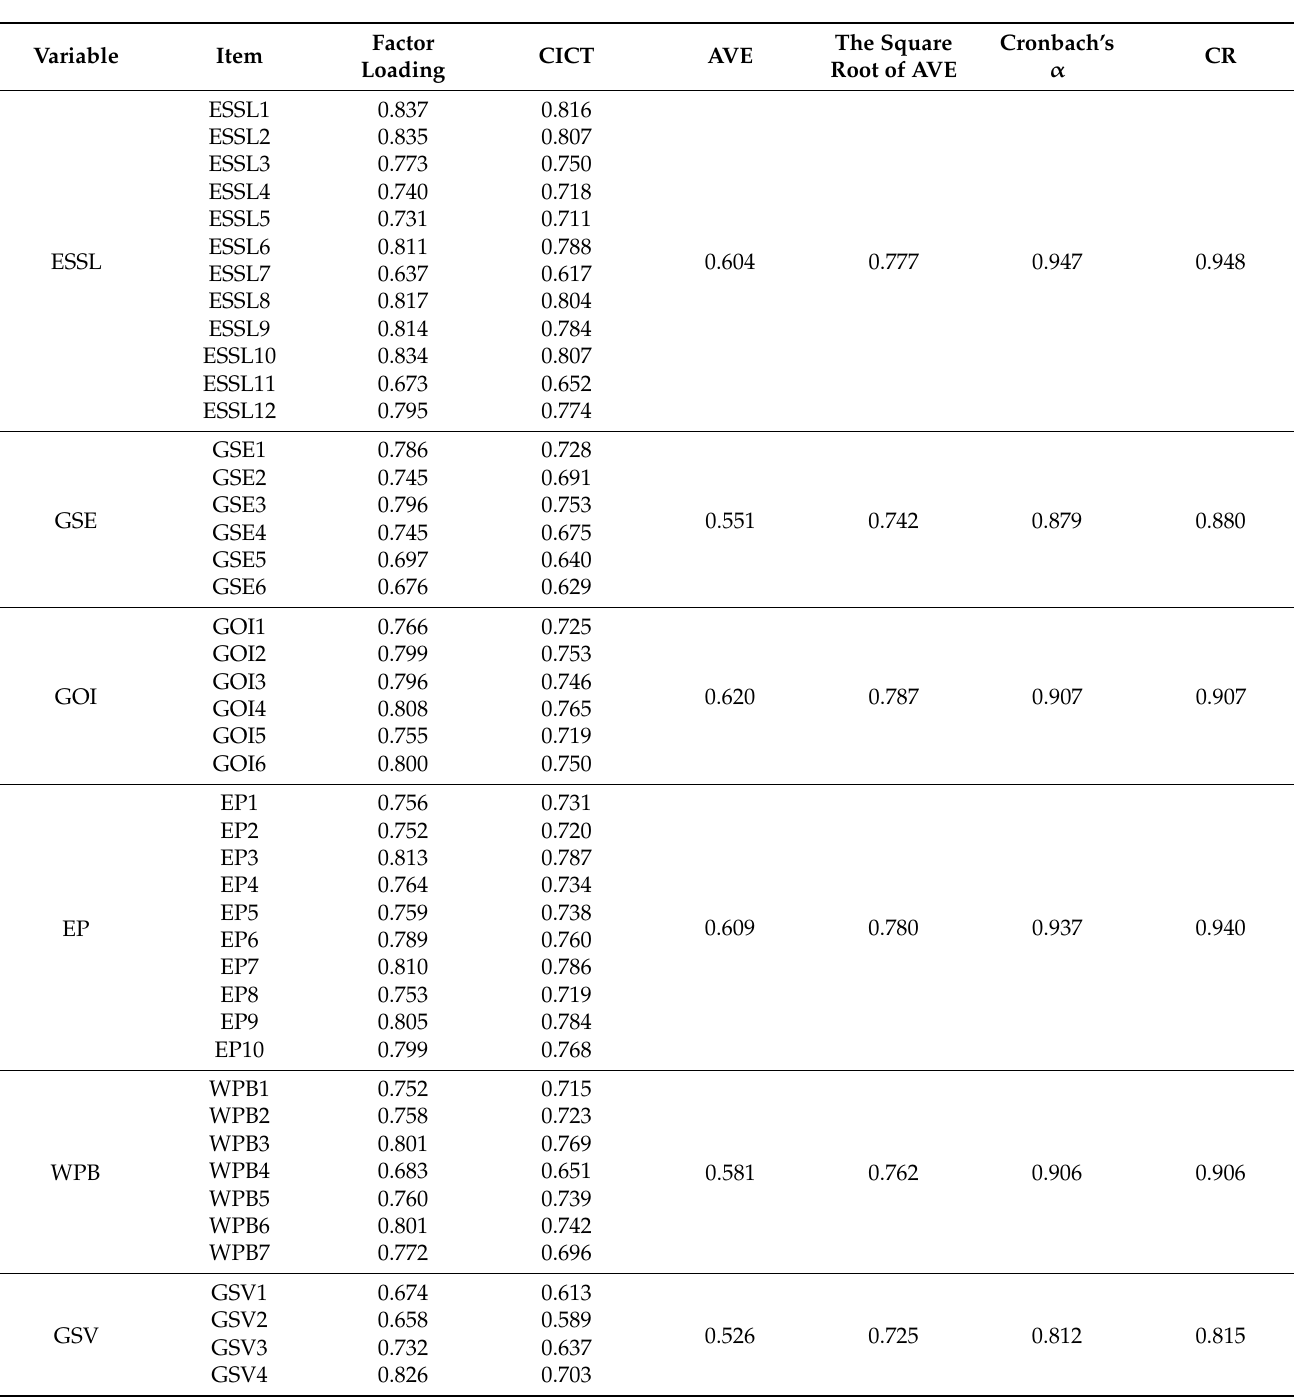
Table 2. Reliability and